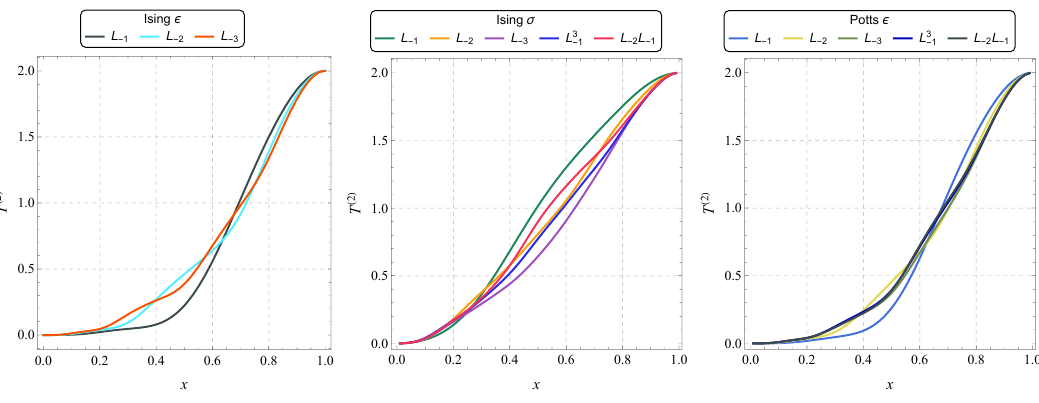
Figure 10 . TSD between different descendants and their primary state | ε i and | σ i in the Ising model and | ε i in the Potts